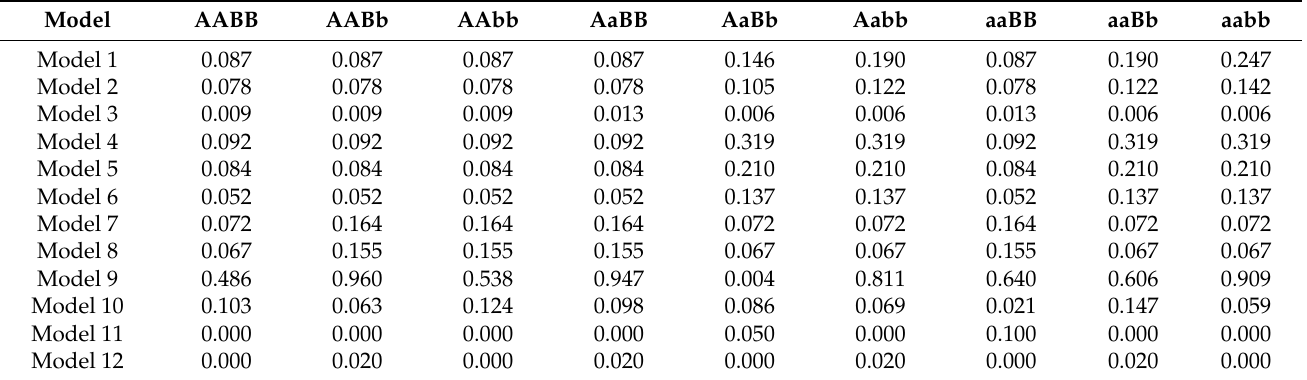
Table 1. Details of the epistatic